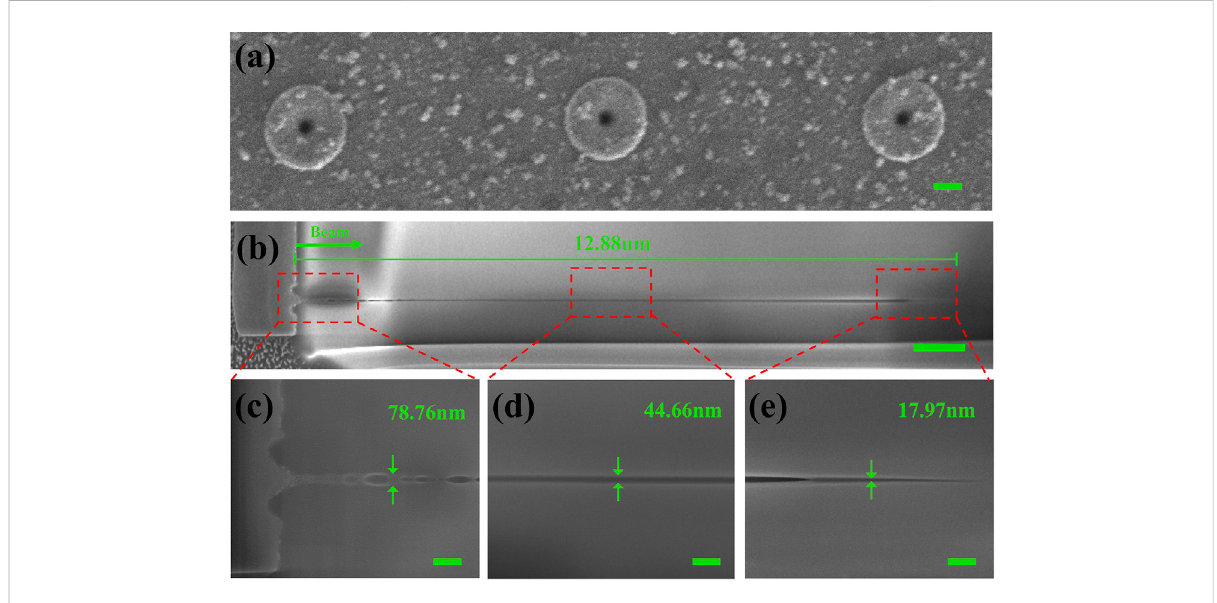
FIGURE 3 FIB pro fi le results of nanochannel one (surface interaction region located at Z = − 1 μ m). (A) SEM image of nanochannel (scale bar 200 nm). (B) FIBresultsoftheoverallnanochannelwithlengthabout12.88 μ m(scalebar1 μ m).Thediametersofthesolid-statenanochannel (C) headregionare ~80 nm, (D) middle region are ~50 nm, and (E) tail region are ~20 nm (all scale bars 200